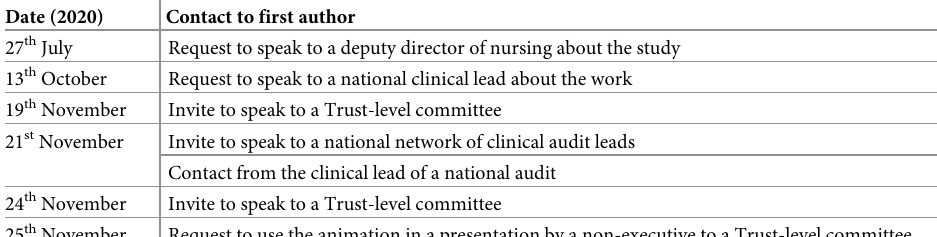
Table 2. A table to show when requests for further information about article 1 were